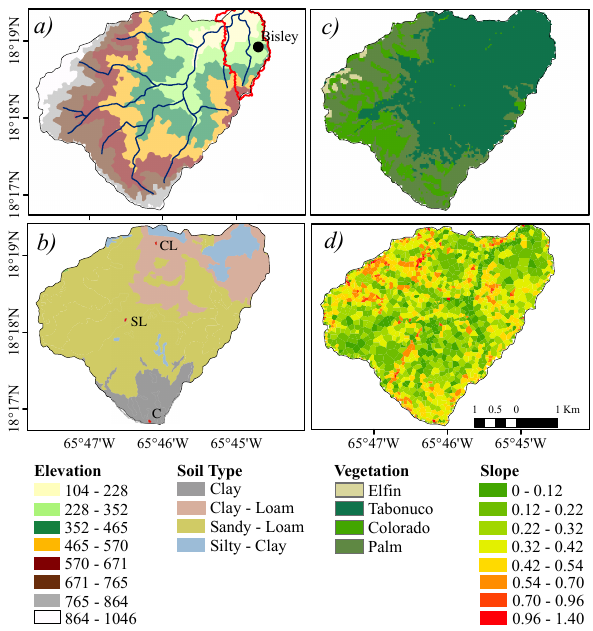
Fig. 2. Summary of the major characteristics of the Mameyes Basin: (a) the range of elevation and the drainage system, with the meteo- rological station, (b) the soil map and the three elements considered in Sect. 6 (in red polygons: C – clay element; CL – clay loam el- ement; and SL – sandy loam element), (c) the vegetation map of the area with its features following closely the elevation range, and (d) the slope distribution of the